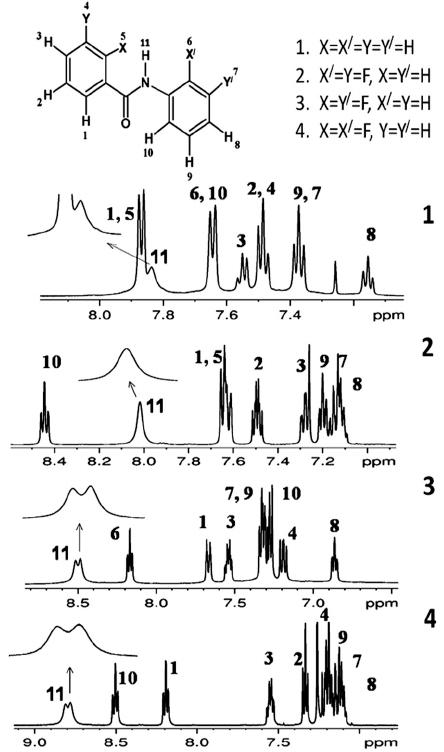
Figure 3. Chemical structures with numbering of interacting spins of fluorine-substituted benzanilides. The 400 MHz 1 H-NMR spectra of molecules 1 , 2 , 3 and 4 respectively (top trace to bottom trace) in the solvent CDCl 3 . The peak assignments have been made based on multiple quantum (MQ)-single quantum (SQ) correlation experiments. The expansions for amide protons in each molecule are depicted by arrows (reproduced from [103]).